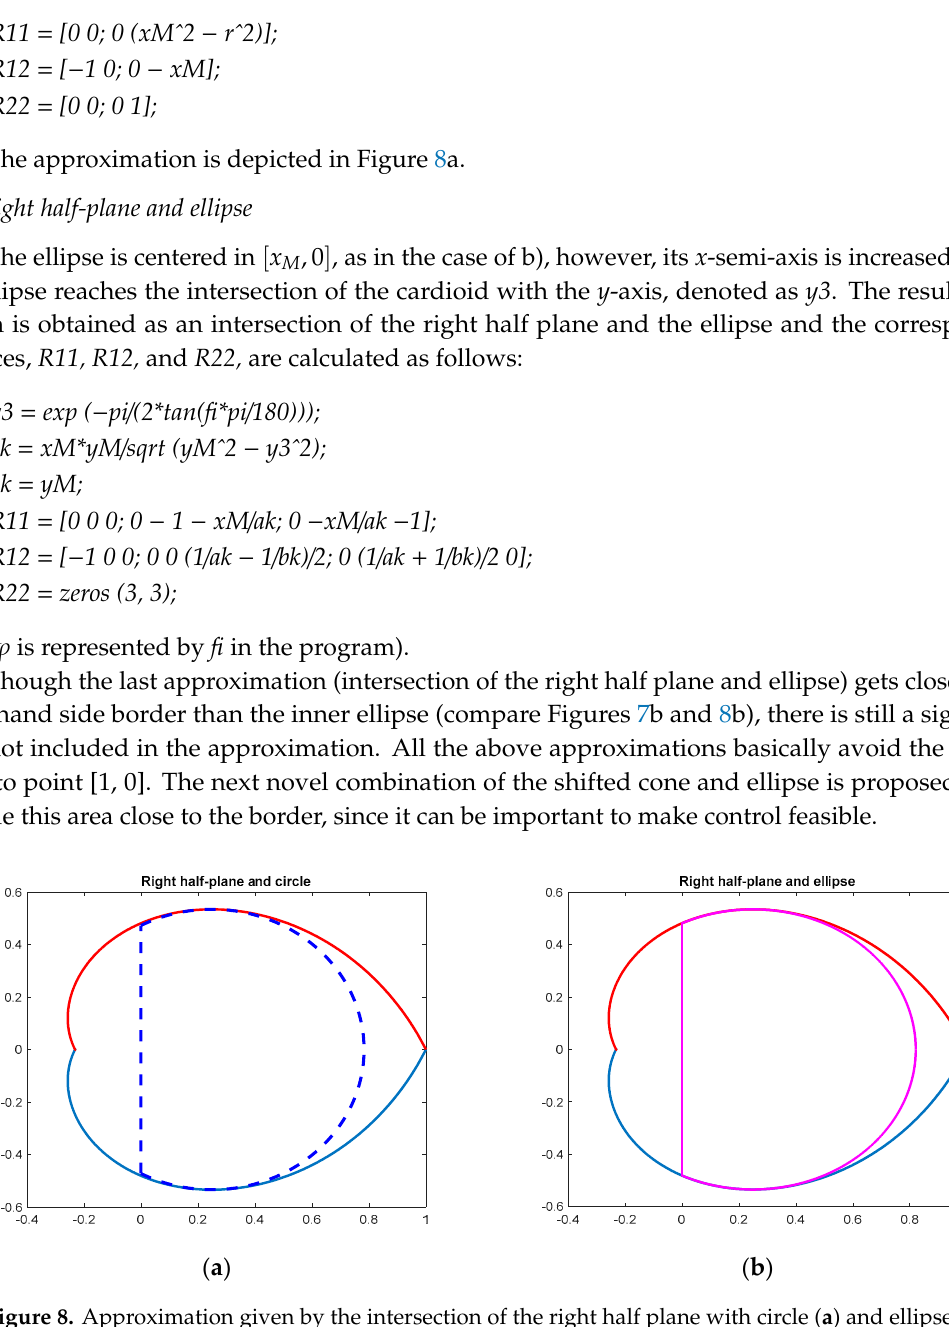
Figure 8. Approximation given by the intersection of the right half plane with circle ( a ) and ellipse ( b ) (65° damping angle).